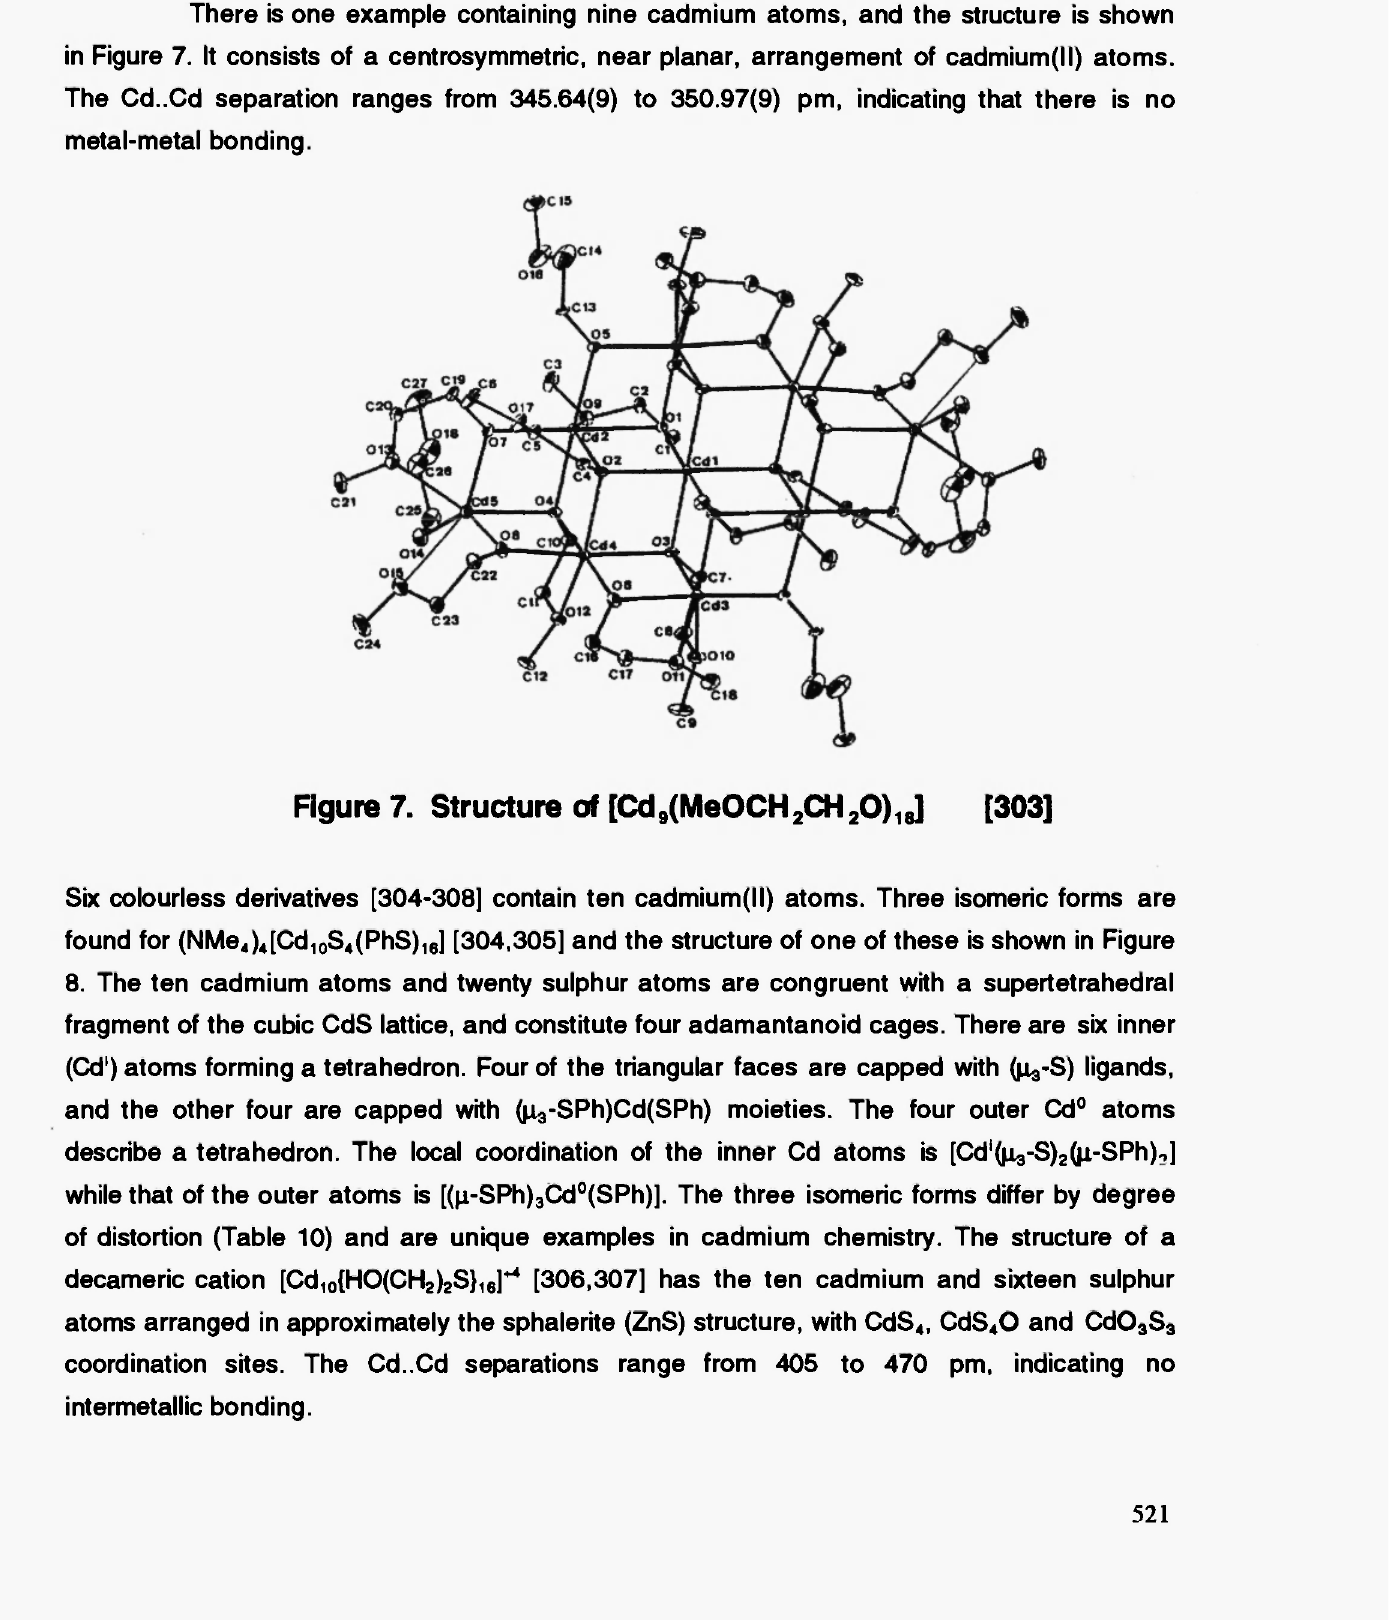
Figure 7. Structure of [Cd